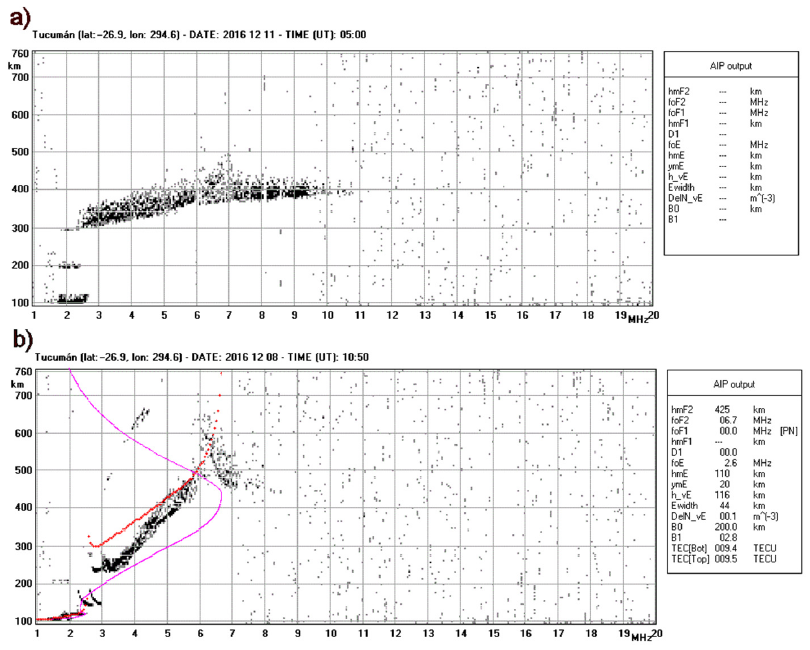
Figure 1. Example of ionograms largely affected by spread F, recorded at the ionospheric station of Tucumán (26.9° S, 294.6° E) on 11 December 2016 at 5.00 UT ( a ), and on 8 December 2016 at 10.50 UT ( b ). As reported in the right ‐ side tables, no outputs are given by Autoscala software for the ionogram in panel ( a ), while erroneous outputs are given for the ionogram in panel ( b ), due to the presence of spread F. The red curve represents the reconstructed ionogram trace, while the magenta line is the restored plasma frequency vertical profile.